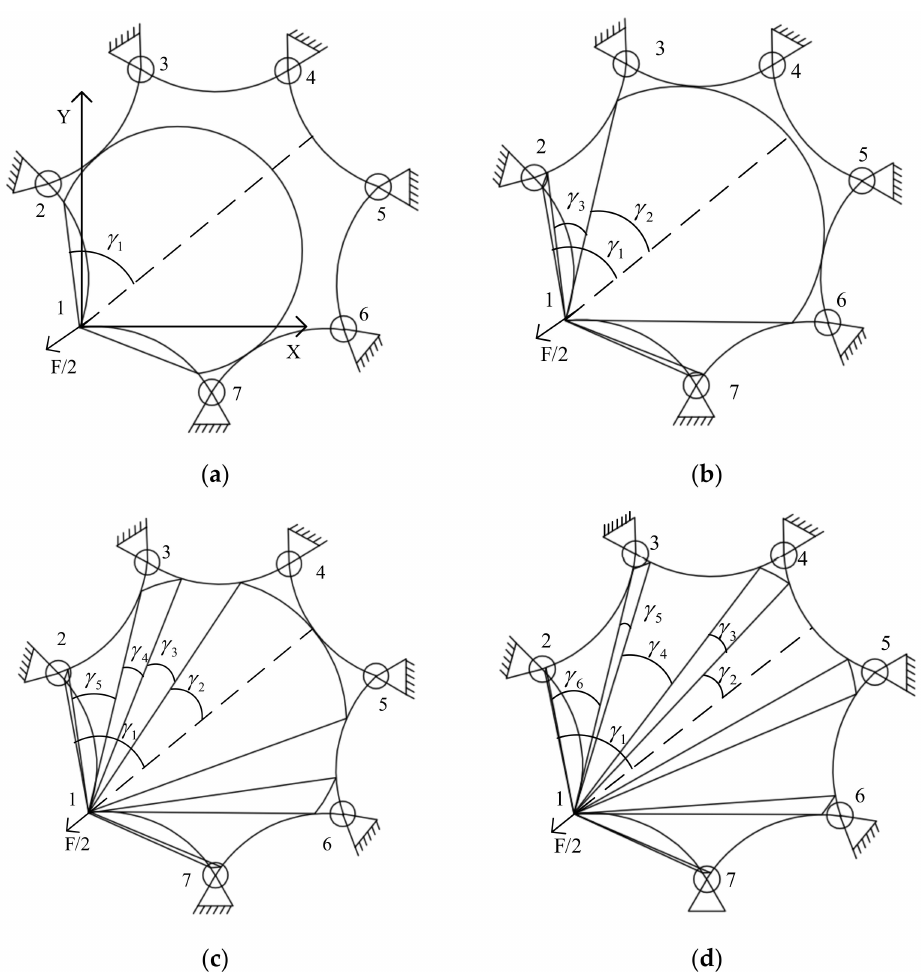
Figure 4. Corner point tensioning positive heptagonal stress area division. ( a ) Region I stress arc distribution; ( b ) region II stress arc distribution; ( c ) region III stress arc distribution; ( d ) region IV stress arc